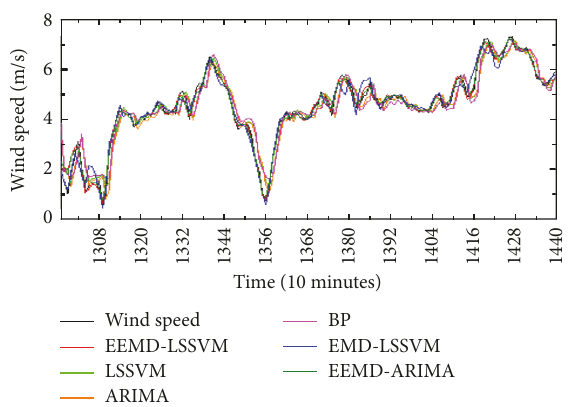
Figure 11: One-step-ahead forecasting results (Case Two). Table 5: Statistics for absolute relative error of each prediction point (Case